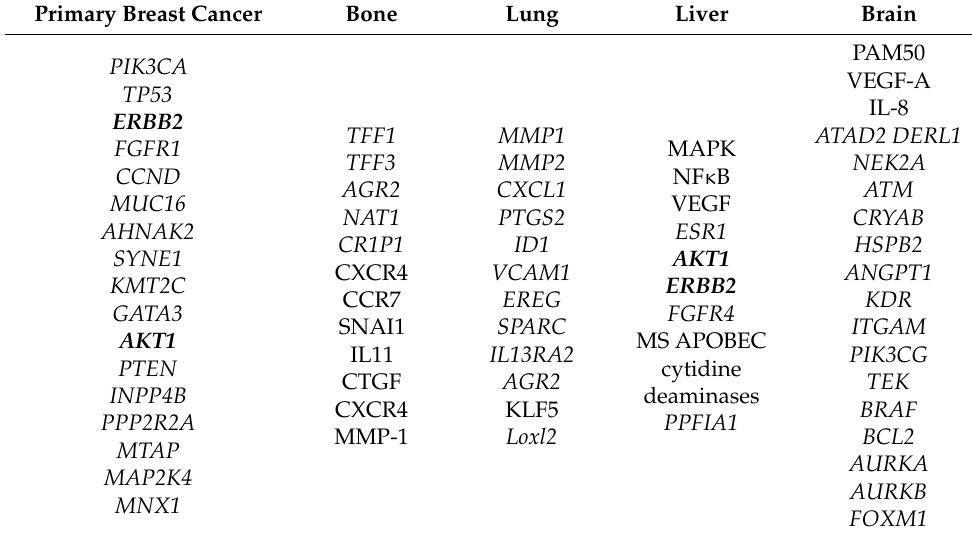
Table 2. Several of the genes linked to primary and metastatic breast cancer discussed in this review. Those presented below are not intended to reflect a comprehensive list, but rather the ones highlighted in this literature review and prevalent throughout literature. References for this table include those provided in the review. Bold indicates genes that our research indicated were commonly involved in more than one site ( ERBB2 , AKT1 ), noting that this is a very limited